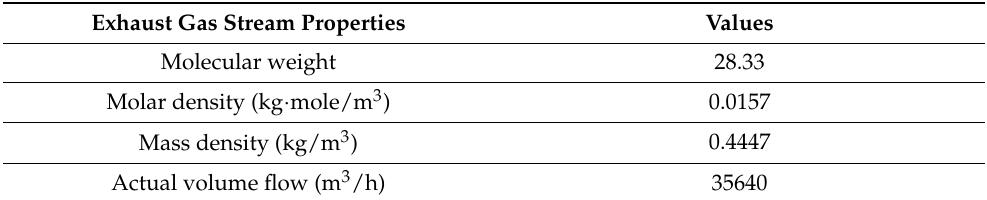
Table 6. The volume flow rate of gas turbine exhaust gas that is necessary to avoid hydrate formation (simulation software